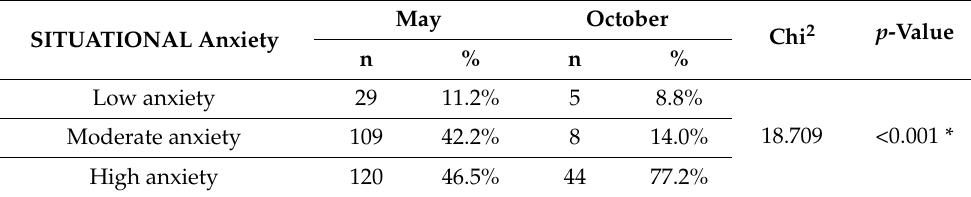
Table 8. Correlations between the time during the wave of the pandemic and the level of situational anxiety (n =